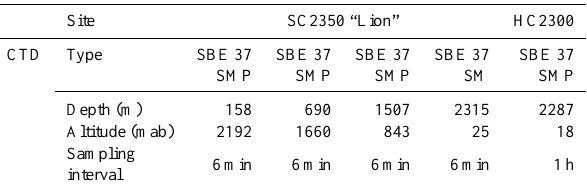
Table 2. Location, water depth and sampling interval of Sea-Bird 37 CTD sensors at mooring lines SC2350 “Lion” and